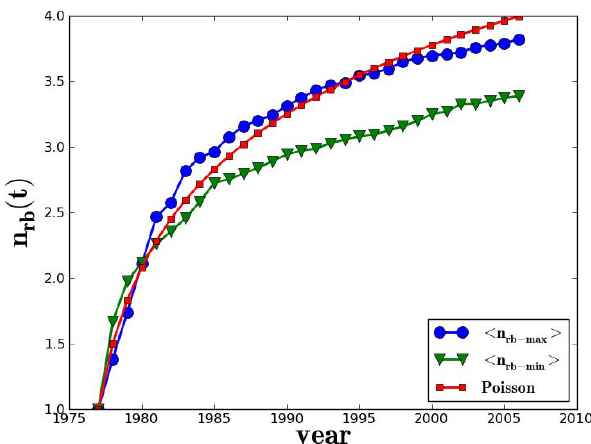
Fig. 6. Mean number of record-breaking maximum temperatures h n i and record-breaking minimum temperatures h n rb - max from MLO are given as a function of time measured forward from 1977 to 2006. Also included is the theoretical prediction for an iid process from Eq. (4).